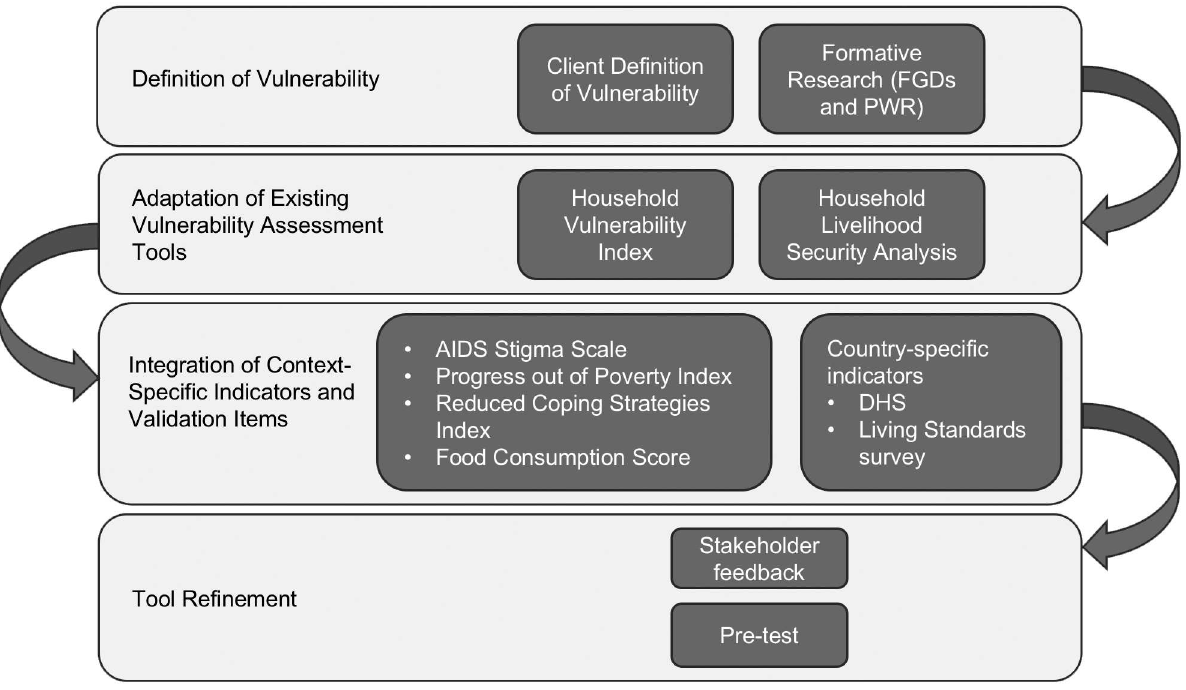
Fig 2. Instrument development